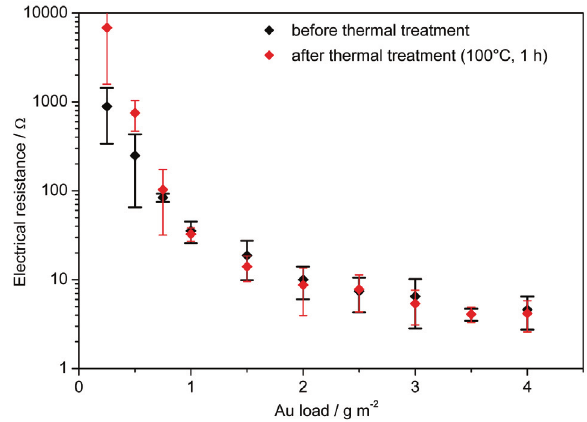
Figure 8. Resistance of Au thin films on glass with various Au loads before (black) and after (red) a thermal treatment at 100 °C for 1